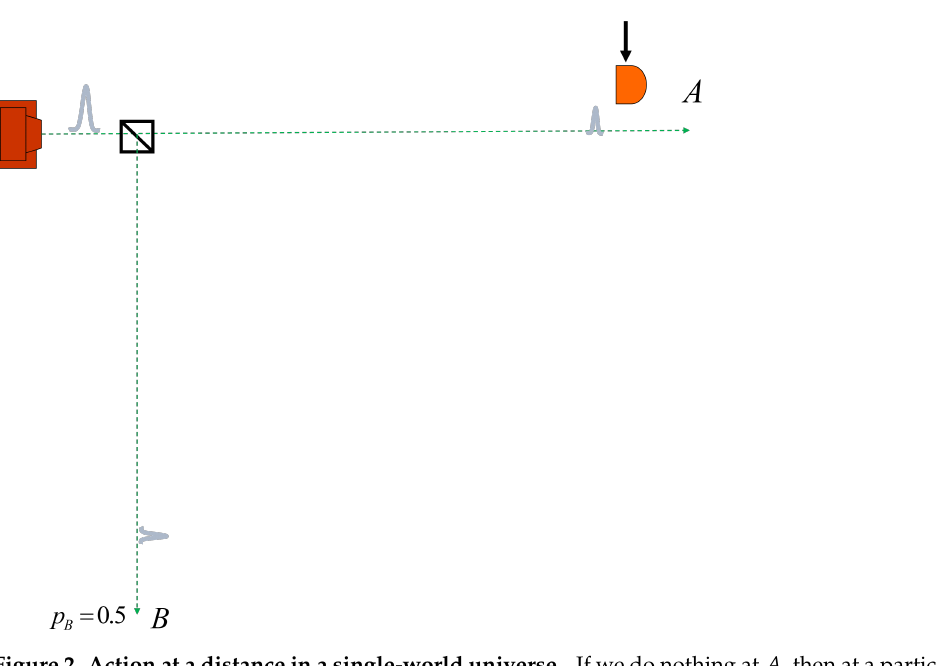
Figure 2. Action at a distance in a single-world universe. If we do nothing at A , then at a particular moment, there will be probability p = 0.5 of finding a photon at a spacelike separated region B . Introducing a detector just before A will lead to a superluminal change in B to p = 0 or p = 1. The change will not be known immediately at B , but it does not change the fact that something in